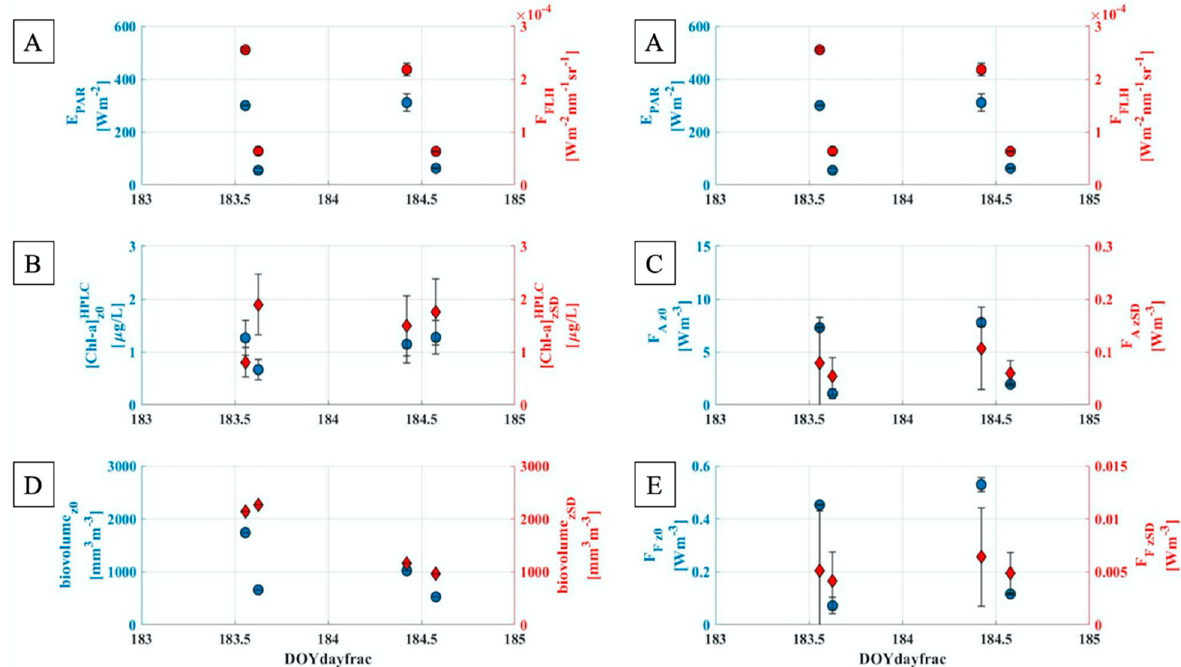
Figure 4. Dots represent variables measured close to the surface (z 0 ), while the diamonds refer to those in the Secchi Disk depth (z SD ). Time is shown as Day-Of-the Year (DOY): 183 is the 2 July 2019 while 184 is the 3 July 2019. First line (( A ) left and right) shows the E PAR (in blue) and F FLH (in red) values in time. All the quantities displayed, except the biovolume ( D ), are mean values, where the error bars correspond to the standard deviations. Concerning [Chl-a] HPLC ( B ) the averages have been carried out on the two replicas available. The F A and F F ( C , E ), instead, have been evaluated according Equations (6) and (7), in which the Satlantic irradiance spectra has been used. In these cases, each point displayed is the result of the average performed on two consecutive sets of measurements carried out. Furthermore, Satlantic acquisition times have been exploited to select the E PAR and F FLH from the ROX time series ( A ).